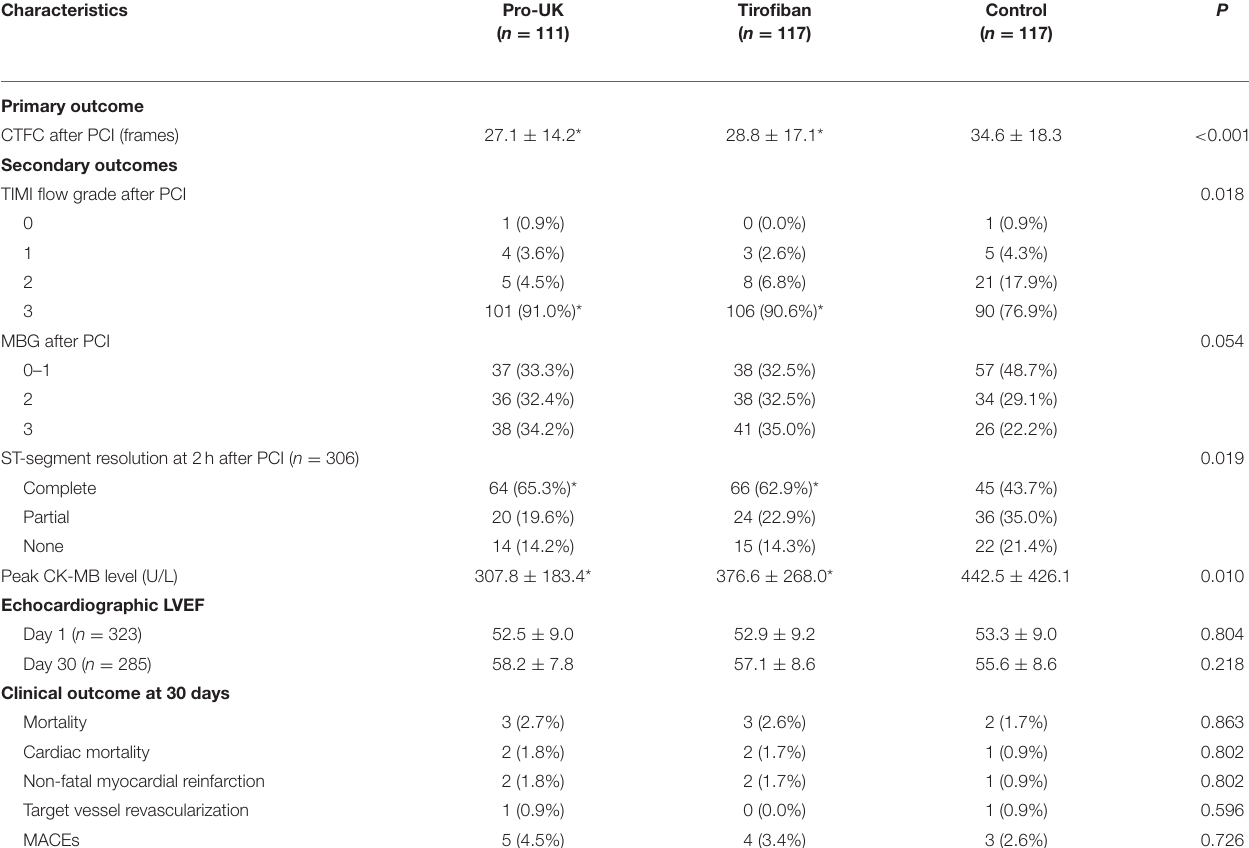
TABLE 3 | Primary and secondary outcomes for the efficacy analyses. Characteristics